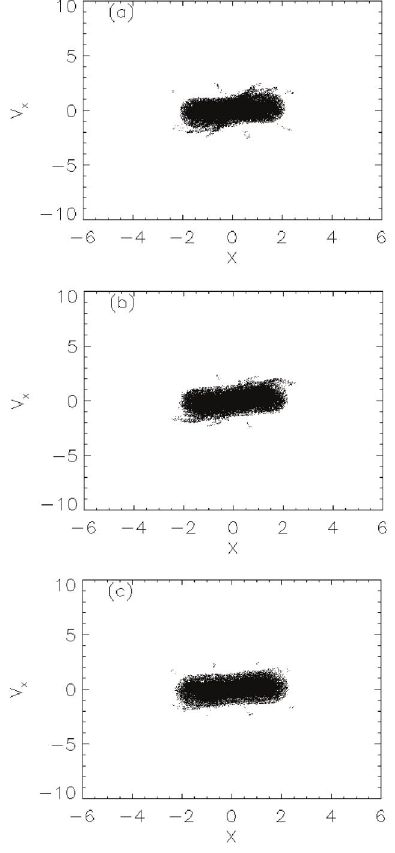
FIG. 9. Phase space distribution of particles just before colli- mation for a beam with nonlinear focusing for (cid:4) (cid:1) (cid:4) a (cid:5) 1.5, (b) 1.35, (c) 1.2.